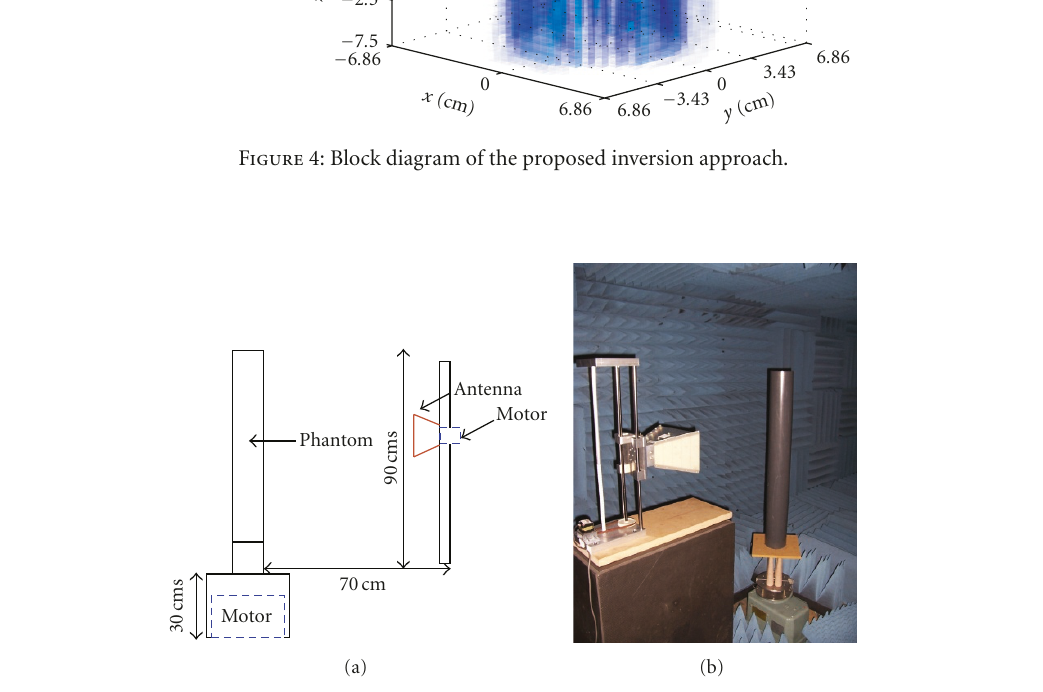
Figure 5: (a) Diagram of the data acquisition system. (b) Photograph of the data acquisition